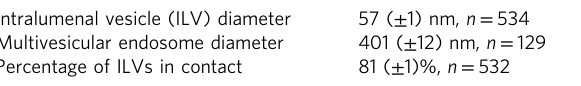
Table 1 Tomogram statistics for one-cell stage embryos Intralumenal vesicle (ILV)